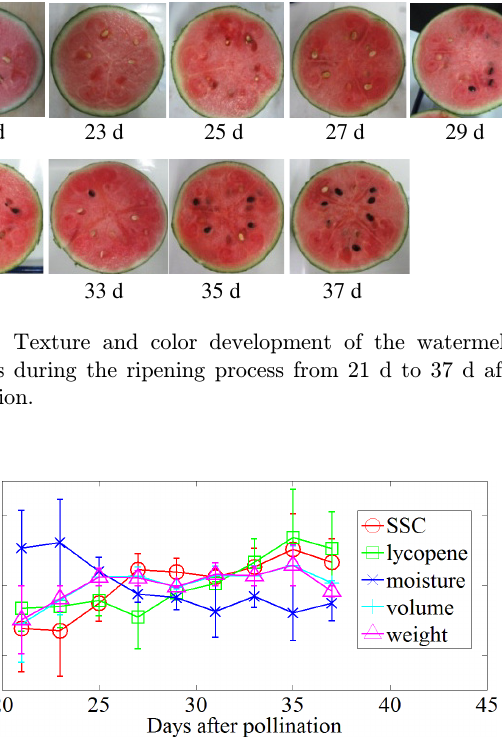
Fig. 4. The VIS-NIR di®use transmittance spectra of water- melon (each spectrum was the average of all the samples at every picking date). (a) Typical original spectra for watermelon; (b) Watermelon spectra with ¯rst derivative.